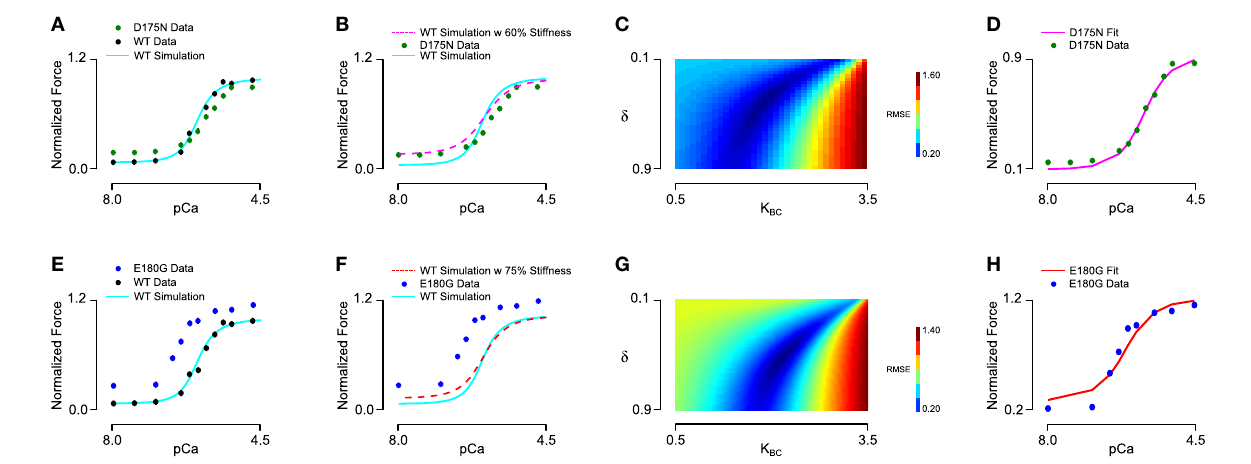
FIGURE 4 | Fitting of wild-type and mutant tropomyosin reconstituted myocardium steady state force production data. (A) Baseline parameters were found that allowed the model to fit the wild-type data, with D175N tropomyosin mutation data shown for comparison. (B) In order to fit the D175N data, tropomyosin stiffness was first reduced by 40% and was not sufficient to fit the data. (C) Duty cycle and BC equilibrium were varied systematically while root mean square error of the model output and the D175N data was calculated, with an error minimum which maintained the baseline duty cycle but decreased the BC equilibrium constant by 15%. (D) The D175N simulation from a prescribed stiffness change and an optimized BC equilibrium decrease show a qualitative fit with the D175N mutant experiment data. (E) Wild-type data and the model fit shown, with E180G tropomyosin mutation data shown for comparison. (F) In order to fit the E180G data, tropomyosin stiffness was first reduced by 25% which was not sufficient to fit the data. (G) The error minimum for the E180G heatmap after applying the 25% stiffness reduction was found to include both a 10% increase in BC equilibrium and a 15% increase in duty cycle. (H) After applying the stiffness change, BC equilibrium change, and duty cycle change, the E180G simulation shows a qualitative fit with the experimental data for the E180G